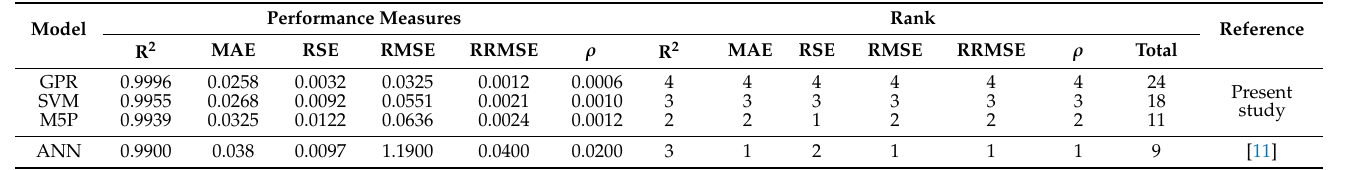
Table 5. Modeling results for the validation set of GPR, M5P, and SVM, and ANN models.